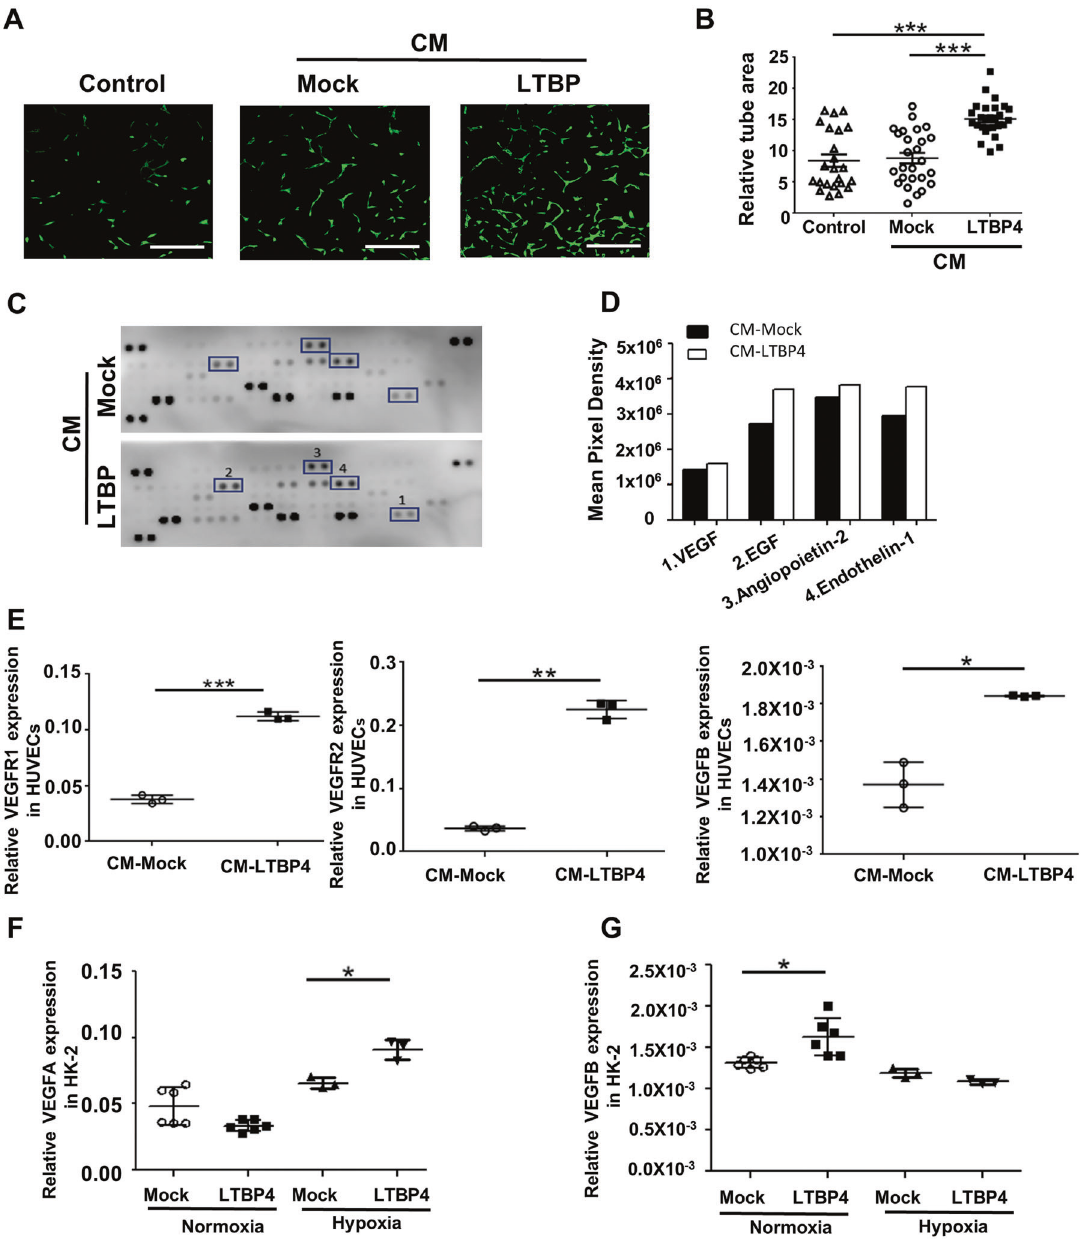
Fig. 4 LTBP4 facilitates angiogenesis in HUVECS and HK-2 cells. Conditioned media (CM) collected from Mock (CM-Mock) or LTBP4- overexpressing HEK293T cells (CM-LTBP4) were used to treat human umbilical vein endothelial cells (HUVECs) and human proximal tubule HK- 2 cells for 48 h, and tube areas and angiogenic factors were studied. A Representative images of tube formation in HUVECs. Control: HUVECs were treated with a regular growth medium. Scale bars, 400 μ m. The results are from three independent experiments. B Densitometric analyses of tube areas in three groups are shown. C, D In proteomic pro fi ling analysis, dot blot pro fi ling for 55 angiogenesis-related proteins showed relatively increasing expression of proangiogenic factors, including VEGF, EGF, angiopoietin-2 and endothelin-1. E Relative expression of VEGFRs and VEGF in HUVECs treated with CM-Mock and CM-LTBP4. CM-LTBP4 stimulated VEGFRs and VEGFB expression. F , G Effect of overexpression of LTBP4 in HK-2 cells. In normoxia, LTBP4 promoted VEGFB expression while, in hypoxia, LTBP4 enhanced VEGFA expression. * p < 0.05, ** p < 0.01, *** p < 0.001; VEGF vascular endothelial growth factor, EGF epidermal growth factor, VEGFA vascular endothelial growth factor A, VEGFB vascular endothelial growth factor B, VEGFR1 vascular endothelial growth factor receptor 1, VEGFR2 vascular endothelial growth factor show the interplay between LTBP4 and angiogenesis in TIF. protein expression, such as angiogenesis and energy usage. The Accumulating evidence has demonstrated that LTBP4 is related complexity of LTBP4 functions might provide a novel target for the treatment of renal fi brosis. tional LTBP4 was observed to induce tubulogenesis in HUVECs by inducing angiogenic factors, including VEGFR1, VEGFR2 and VEGFB; moreover, LTBP4 induced upregulation of VEGFA in